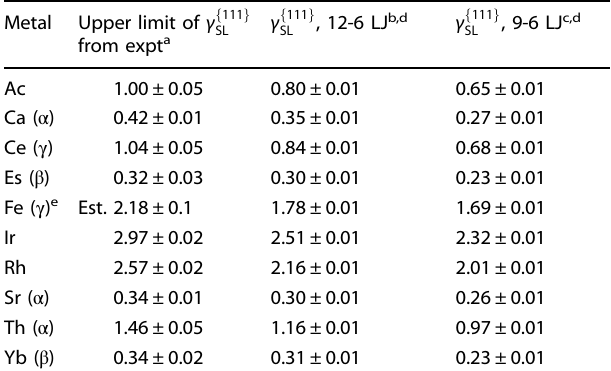
Table 4. The metal – water interface tension γ f 111 g limits from experimental data and values from the simulation (in J m − 2